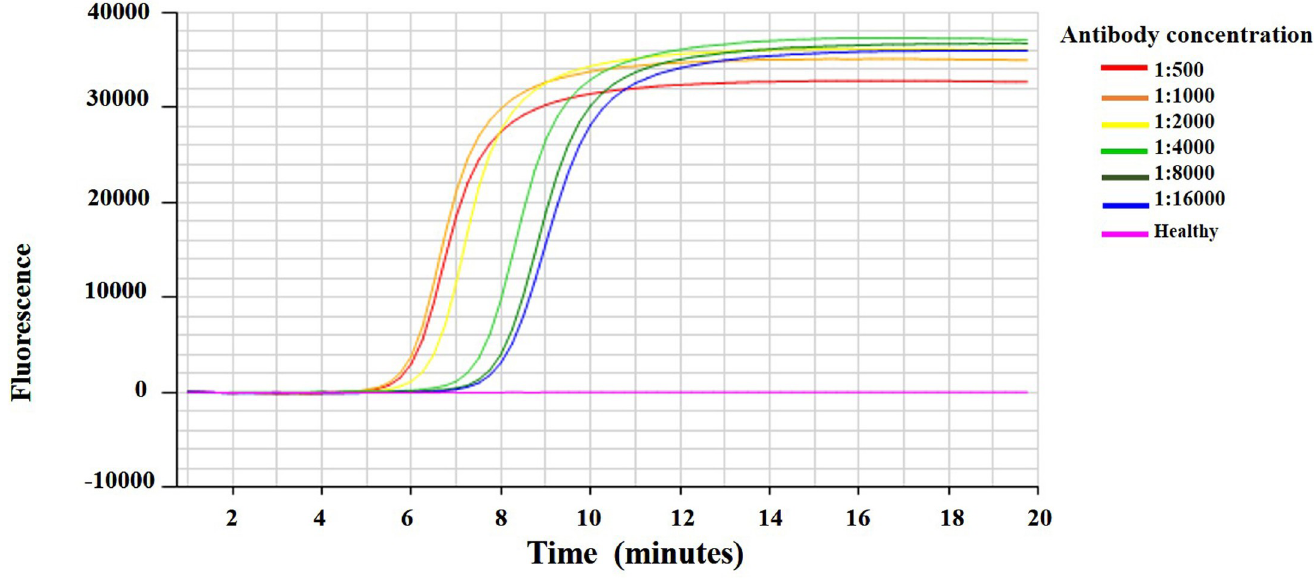
Fig 4. Optimization of Citrus tristeza virus (CTV) IgG against the CA-VT-AT39 infected citrus leaf crude extracts by Immunocapture RT-LAMP assay. Amplification curve of healthy and CA-VT-AT39 infected citrus leaf tissue extract using two-fold serially diluted (1:500 to 1:16,000) CTV specific antibody in IC-RT-LAMP assay. VT detection times for the CA-VT-AT39 extract were 6:45, 6:45, 7:05, 8:15, 8:45, and 9:00 (min:sec) at 1:500, 1:1000, 1:2000, 1:4000, 1:8000 and 1:16000, respectively.